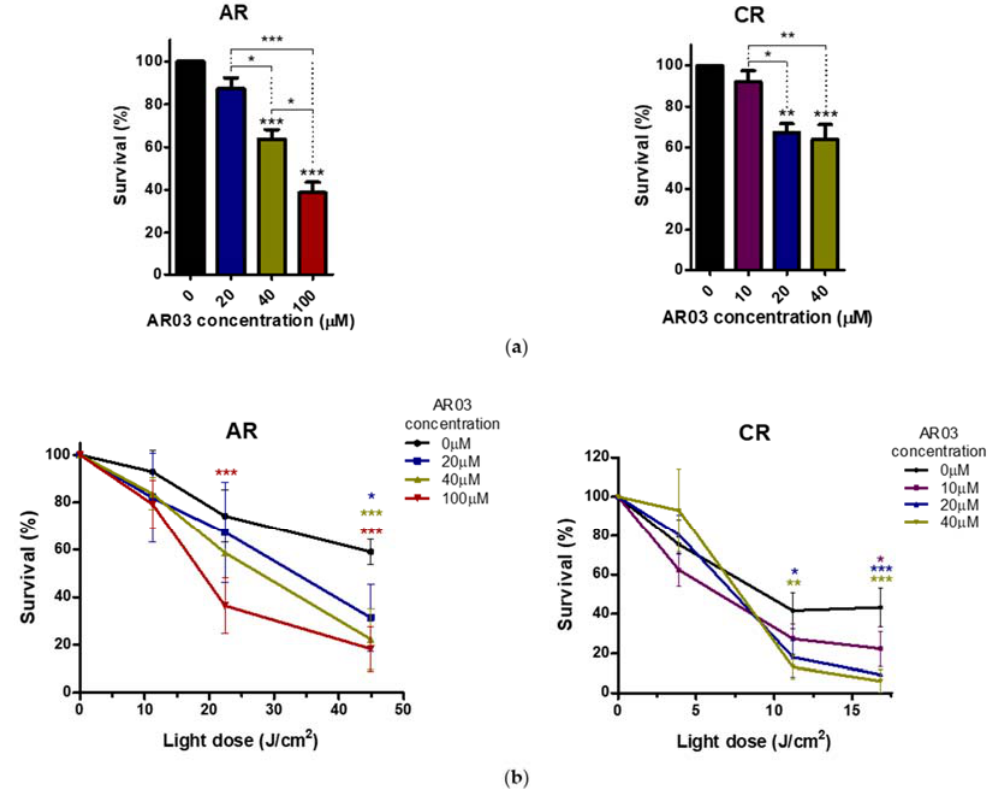
Figure 7. The effect of APE1 inhibition on PDT-resistant cancer cells. ( a ) AR03 effect on cancer cell lines. ( b ) Sensitization of cancer cells resistant to PDT with APE1 inhibitor. Statistical significance was calculated by one-way or two-way ANOVA followed by the Bonferroni test (* p ≤ 0.05, ** p ≤ 0.01, *** p ≤ 0.001).